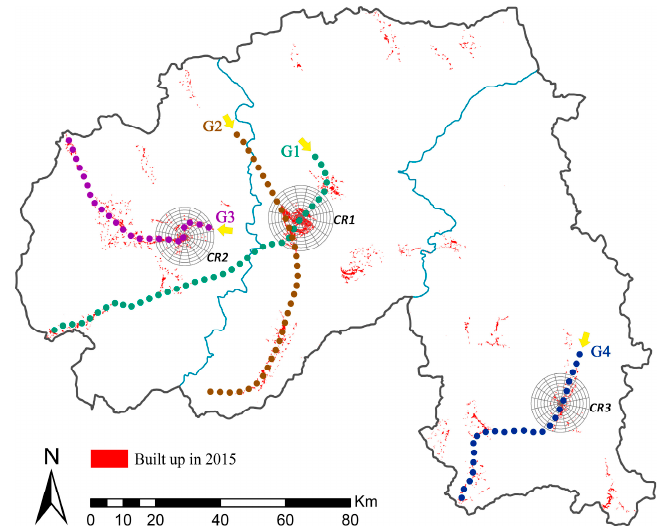
Figure 2. Gradient-direction maps and urban-rural gradients for the analysis (some points of urban-rural gradients are not shown due to the plotting scale). Gradient-direction maps: CR1 for the city proper; CR2 for the county town of Menghai; CR3 for the county town of Mengla. Urban-rural gradients: G1 and G2 went through the city proper and smaller towns; G3 went through the county town of Menghai and Mengzhe town; G4 went through the county town of Mengla and Mengpeng town.